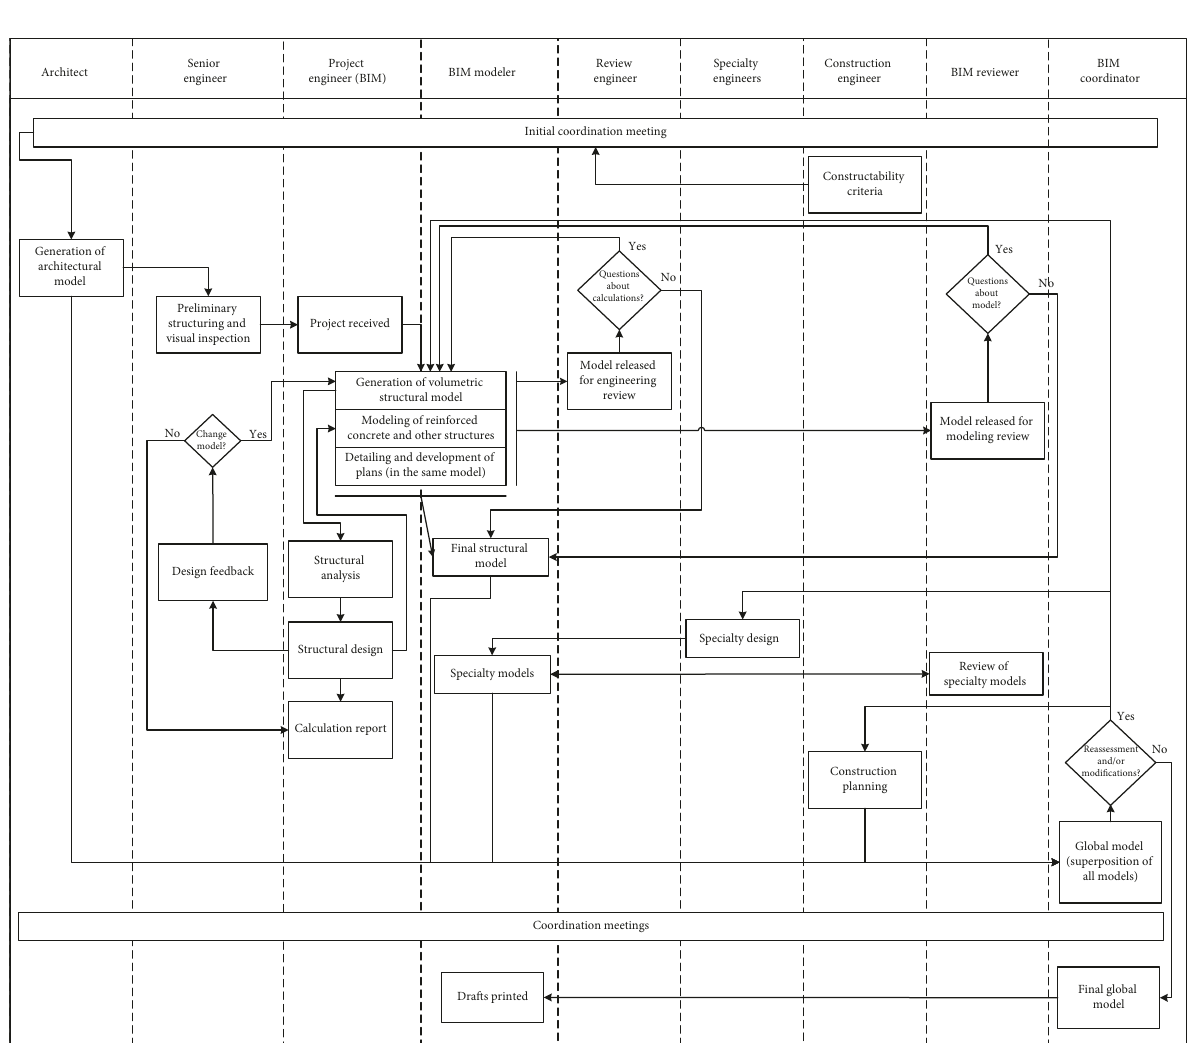
Figure 4: Extreme collaboration environment [38].